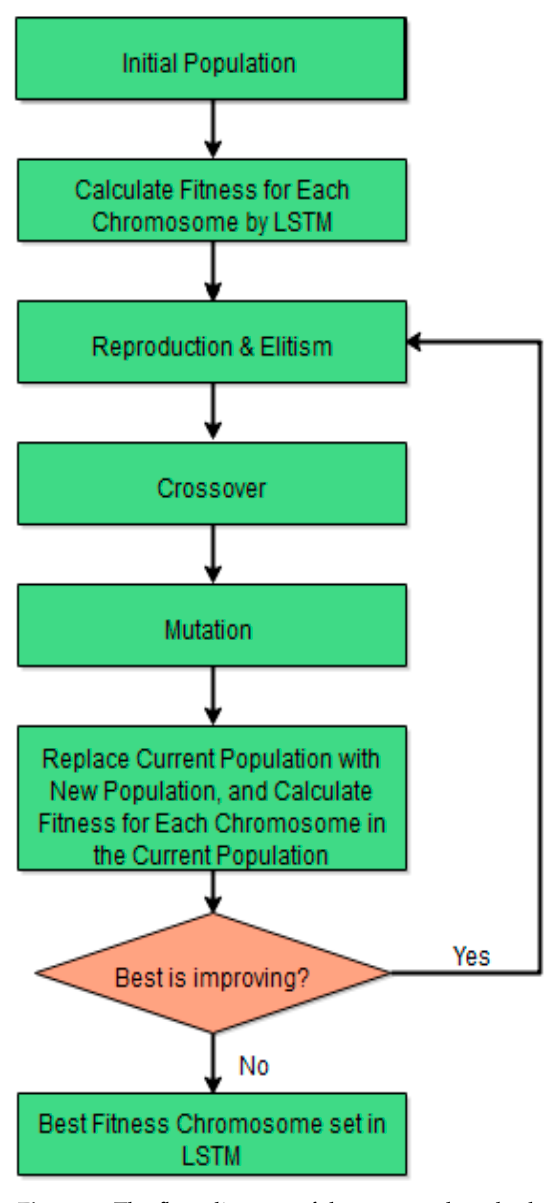
Figure 3. The flow diagram of the proposed method.